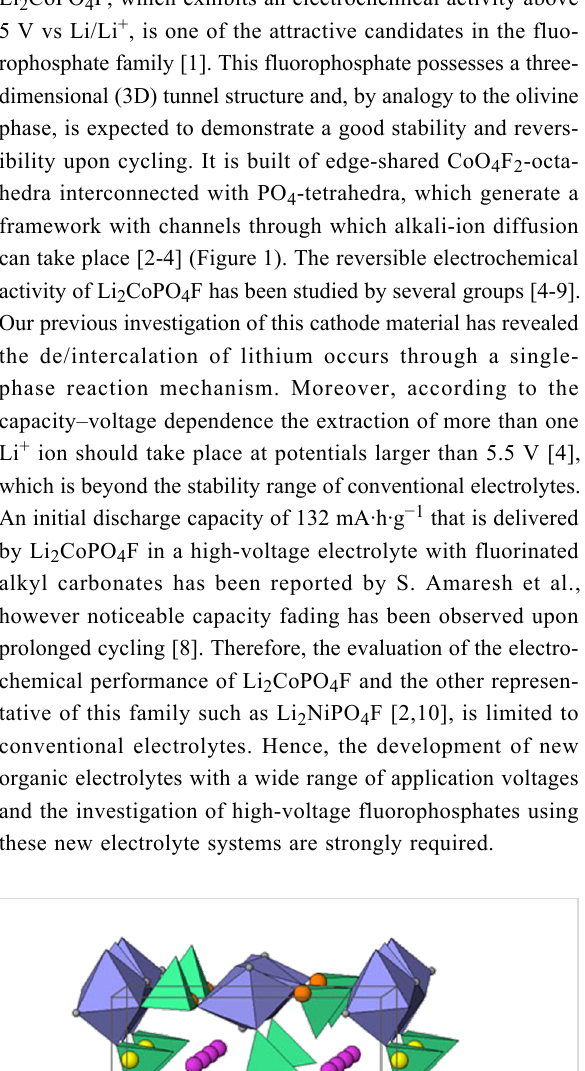
Another way to explore this fluorophopshate family is to adjust the operating voltage of these compounds to values that